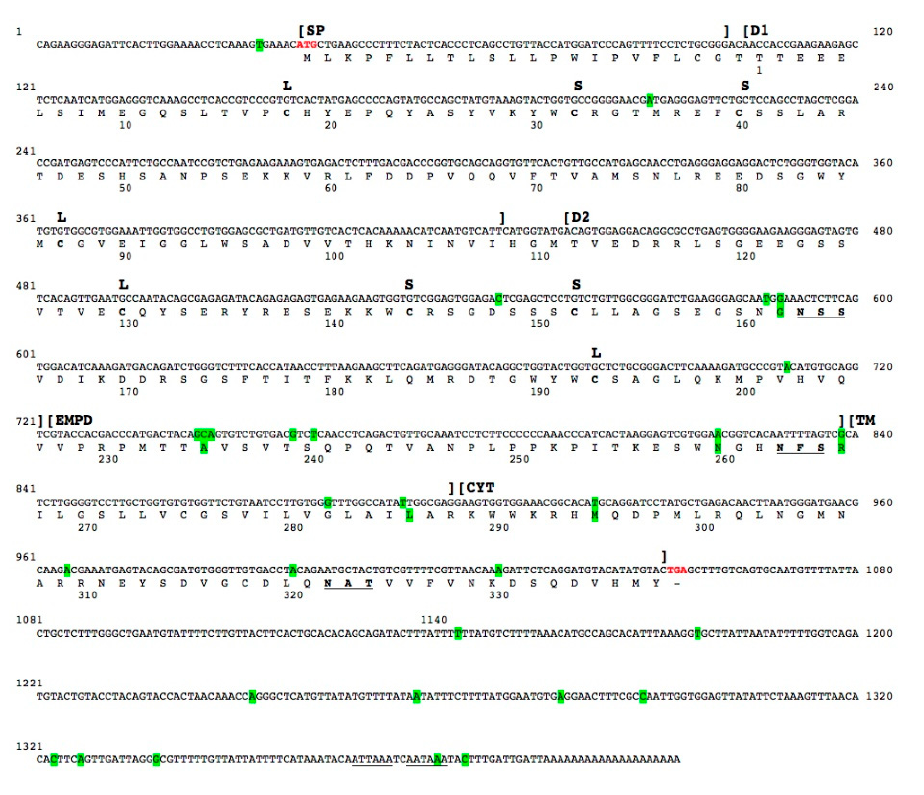
Figure 5. Alignment of the T. bernacchii pIgR genomic sequence with that of the three transcript variants. Of the pIgR genomic sequence (gT.ber), retrieved from the T. bernacchii genome, only the region spanning the 3 ′ end of the fourth intron and the 5 ′ end of the EMPD exon 2 is shown. Two pIgR variants (T.ber variant X1 and T.ber variant X2) are predicted from the genome; the pIgR cDNA variant (T.ber cloned) has been isolated in the present study. The canonical acceptor splicing site is depicted in red. The cryptic splicing site is in bold red and underlined. Gaps are indicated by dashes. Identical nucleotides are indicated with an asterisk below the alignment; positions differing in one nucleotide are marked by dots.